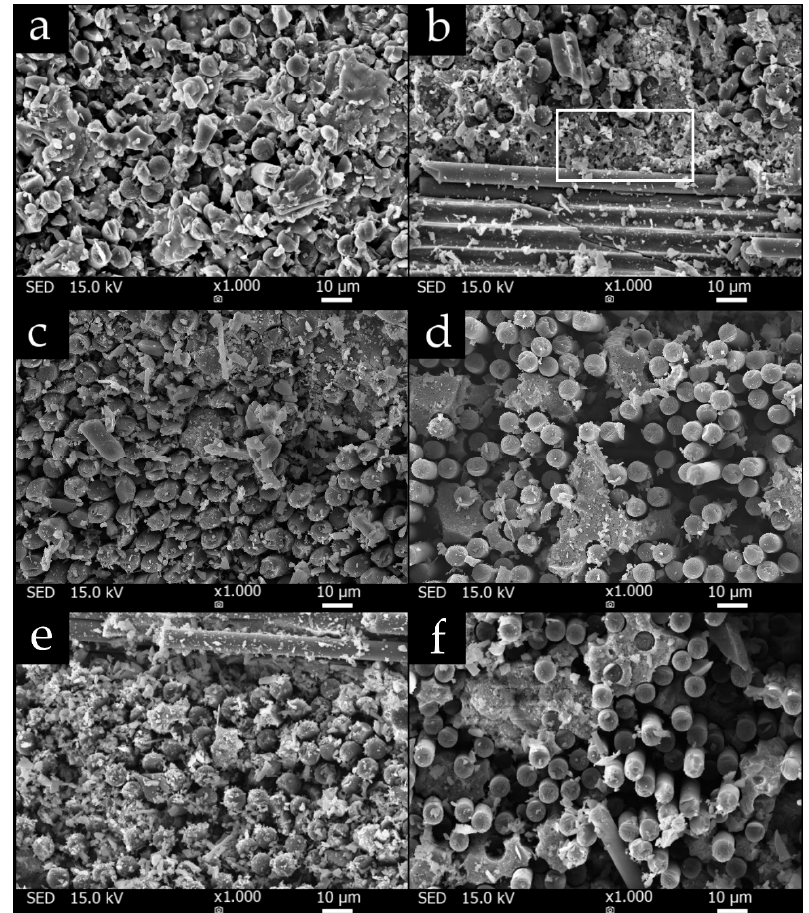
Figure 9. Photos of composite samples ( a ) C 0 -25, ( b ) C 0 -500, ( c ) C 8 -25, ( d ) C 8 -500, ( e ) C 16 -25, ( f ) C 16 -500 obtained using scanning electron